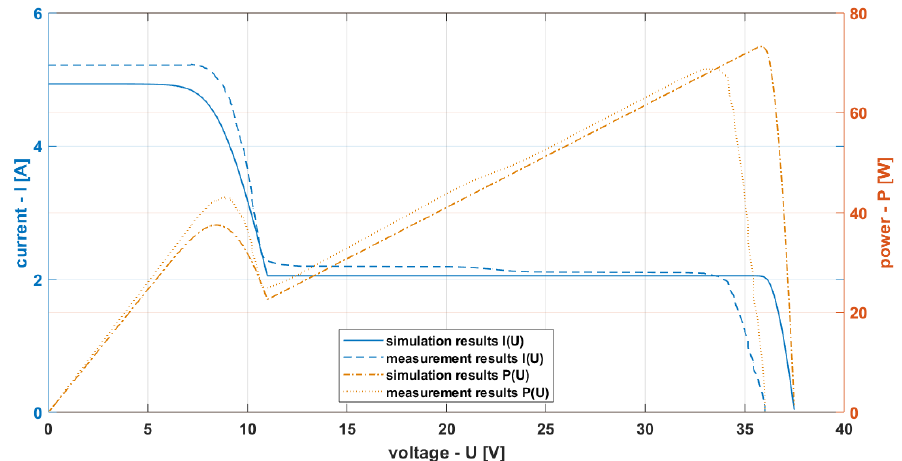
Figure 10. I–V characteristics of PV module MonoSol 260 EX made with partial shading. For detailed comparison of measurement and simulation results, see Table 2. Marking of measurement point M2 (four PV cells were shaded; the exact measurement time was 11:22 a.m.).